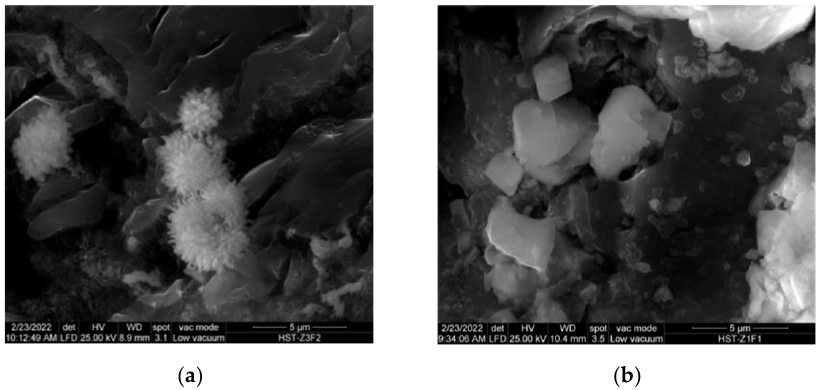
Table 5. Mean carbonation depth and standard deviation (SD). Mortar